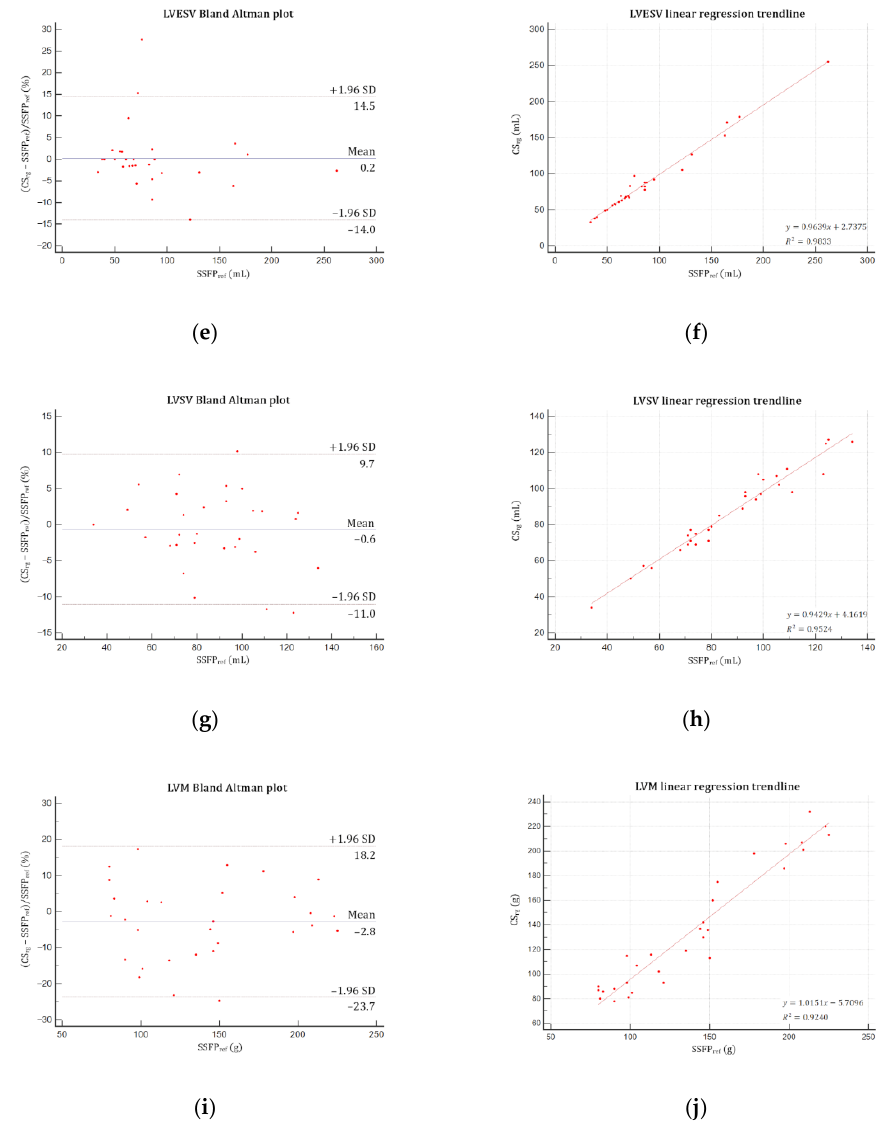
Figure 4. Bland–Altman plots and linear regression trendlines applied to left ventricular functional parameters quantifications. Left column: Bland–Altman plots for ( a ) LVEF, ( c ) LVEDV, ( e ) LVESV, ( g ) LVSV and ( i ) LVM. Solid blue lines are the mean differences between parameters measured with SSFP ref and CS rg sequences and dashed red lines are the 95% limits of agreement. Right column: linear regression trend lines for ( b ) LVEF, ( d ) LVEDV, ( f ) LVESV, ( h ) LVSV and ( j ) LVM. Abbreviations: SSFP ref , reference steady-state free precession; CS rg , retrogated compressed sensing; SD, standard deviation; LVEF, left ventricular ejection fraction; LVEDV, left ventricular end-diastolic volume; LVESV, left ventricular end-systolic volume; LVSV, left ventricular stroke volume; LVM, left ventricular mass.